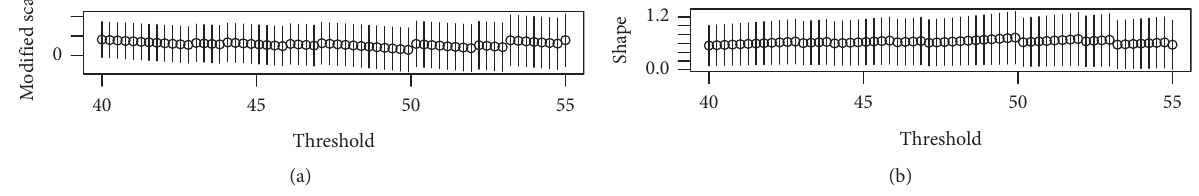
Figure 4: Figure of calibration scale and shape parameters of damage areas.